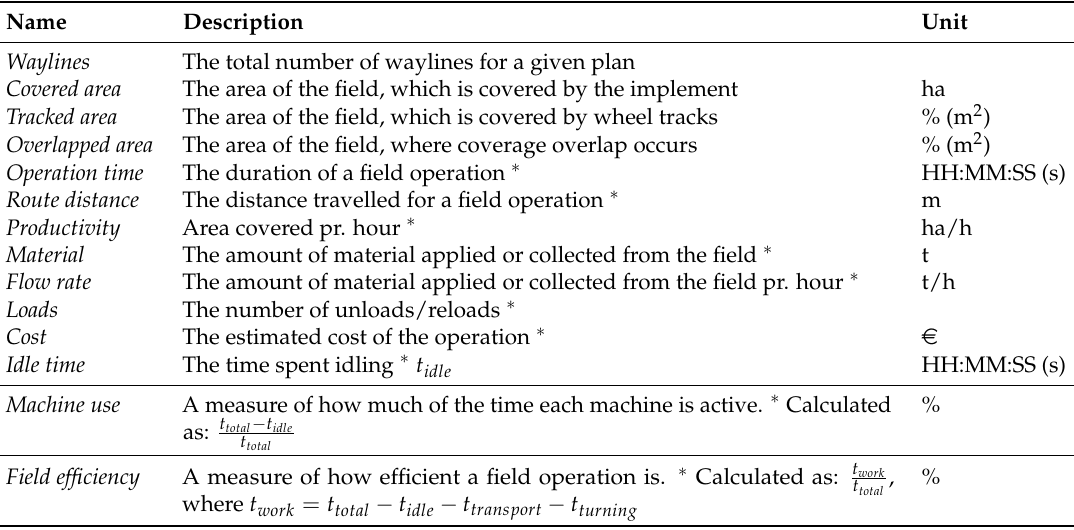
Figure 5. Route plan for a harvest operation. Table 2. List of calculated KPIs. KPIs marked with an ∗ is calculated for each machine and as a total for the complete